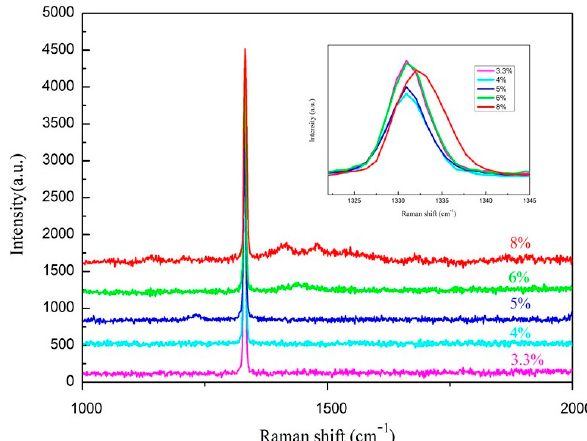
Figure 6. Raman spectra of as-grown diamond films when methane concentration varying from 3.3% to 8%. Figure 7. The FWHMs of X-ray rocking curves and Raman spectra of as-grown diamond films with methane concentration varying from 3.3% to 8%.